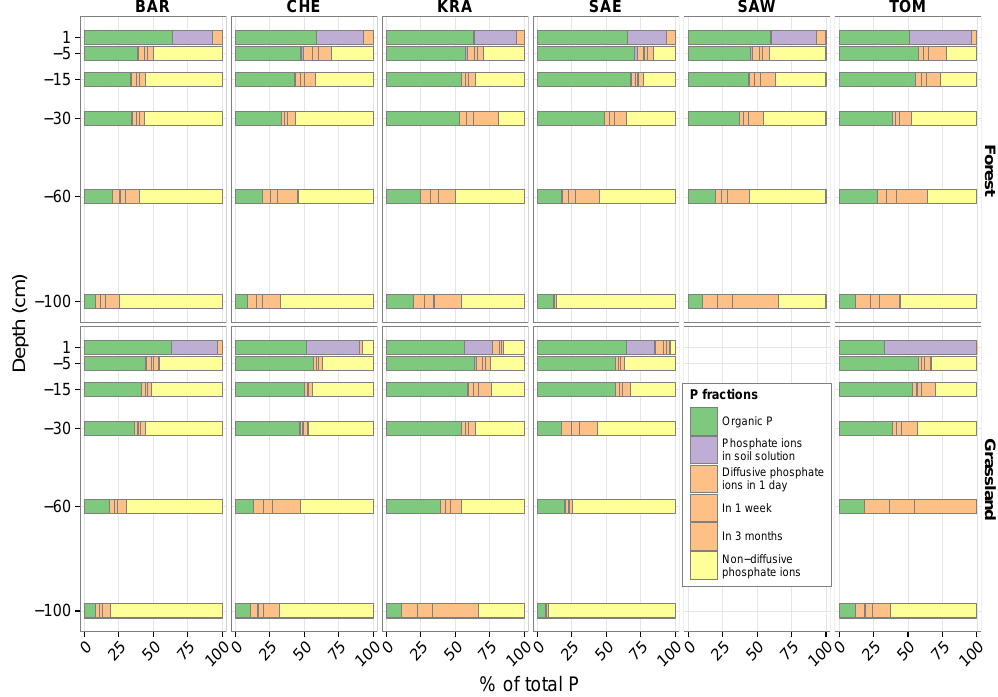
Figure 2. Structure of total P ( P tot ) in terms of P ions in the soil solution ( Q w ), diffusive P ions on different timescales ( P r ), and non- diffusive P ions or those that are diffusive in more than 3 months (P non-diff ). Each fraction of P is expressed as a percentage of P tot . Note that the diffusive fractions for the shorter times are included in the diffusive fraction for the longer time (e.g. P r (1day) is included in P r (1week) and they are both included in P r (3months)). Depth “1” is the litter. “Litter” means all the dead plant material deposited on the soil surface (senescing leaf litterfall, small branches and senescing understorey vegetation in forests; senescing herbaceous vegetation in grasslands), i.e. mainly OL and OF horizons and possibly OH (at BAR, CHE, KRA and SAE) at the date of